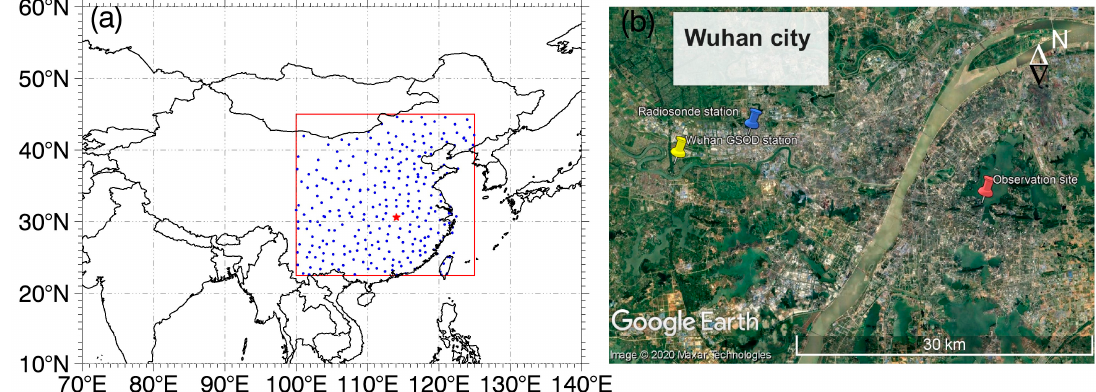
Figure 2. ( a ) Locations of the 268 GSOD stations (blue dots) over central and eastern China (100–125° E, 22.5–45° N) and Wuhan city (red asterisk). ( b ) Locations of our observation site (red pin), GSOD station (yellow pin), and radiosonde station (blue pin) in Wuhan city. The image in panel ( b ) is reproduced with permission from Google Inc., 2020.